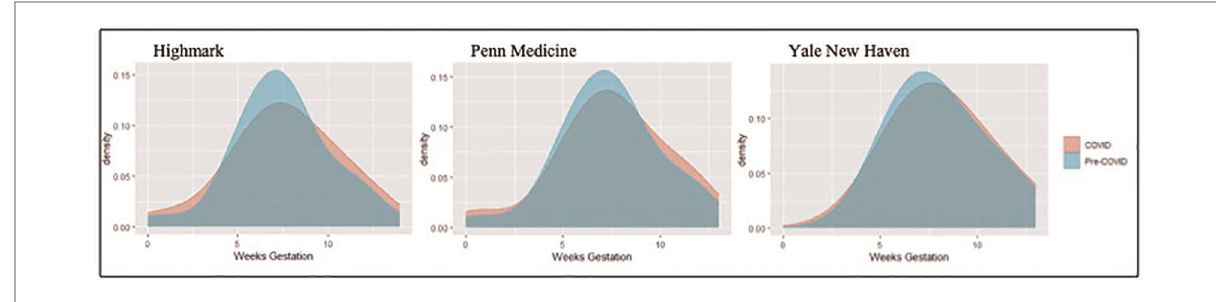
FIGURE 2 Distribution of completion of fi rst trimester ultrasound across the three data